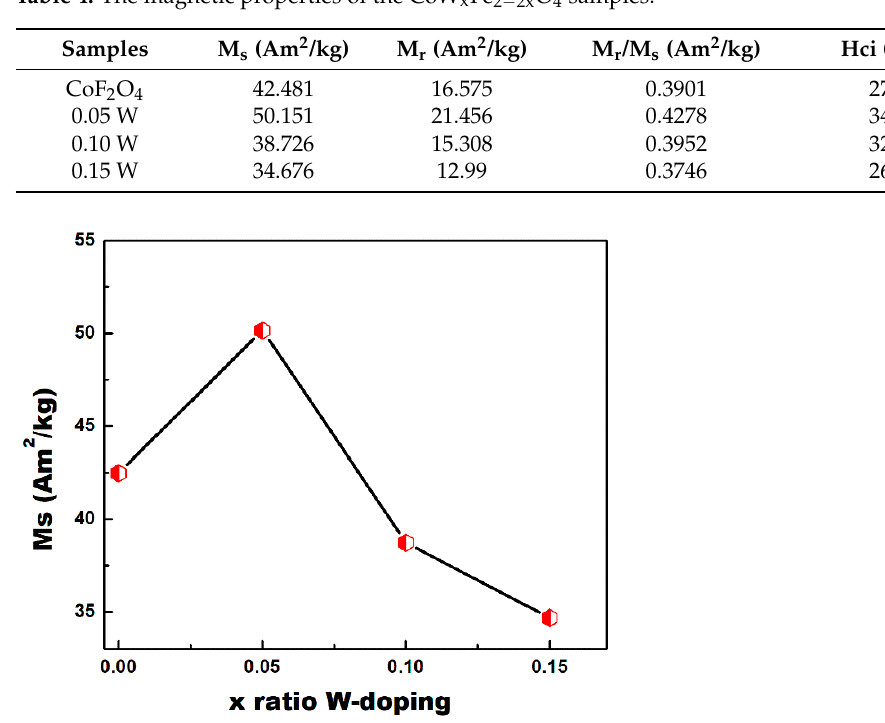
Figure 11. Variation of saturation magnetization (Ms) with W-doping level. Table 4. The magnetic properties of the CoW x Fe 2-2x O 4 samples.